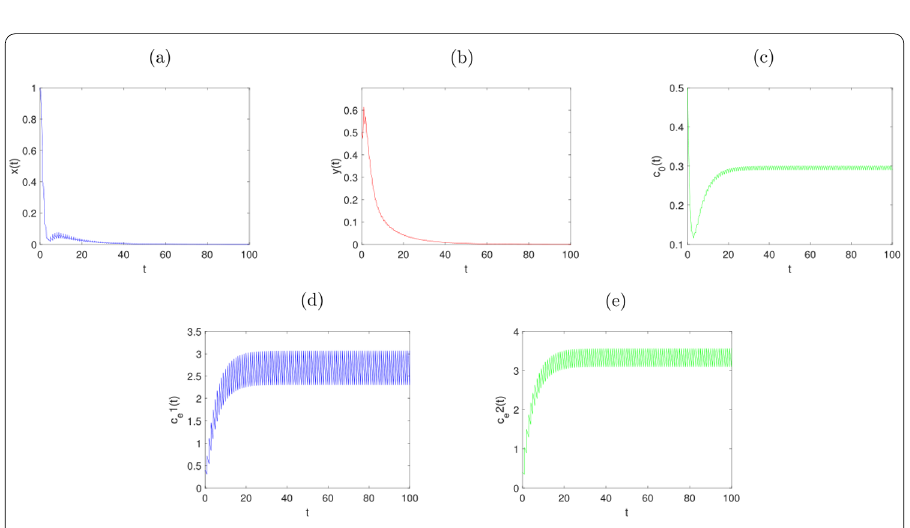
Figure 3 Globally asymptotically stable population-extinction periodic solution of system (2.1) with x ( t ) = 1, y ( t ) = 0.5, c o ( t ) = 0.5, c e 1 ( t ) = 0.4, c 1 = 0.1, d 1 = 0.1, β 1 = 0.01, d 2 = 0.3, β 2 = 0.01, f = 0.1, g = 0.4, m = 0.5, h 1 = 0.3, h 2 = 0.15, a = 0.4, b = 1, c 2 = 0.5, d 3 = 0.1, E 1 = 0.08, d 4 = 0.1, E 2 = 0.05, u 1 = 0.2, u 2 = 0.03, d = 0.5, v 1 = 0.4, v 2 = 0.5, l = 0.5, τ = 1; ( a ) time series of x ( t ); ( b ) time series of y ( t ); ( c ) time series of c o ( t ); ( d ) time series of c e 1 ( t ); ( e ) time series of c e 2 ( t